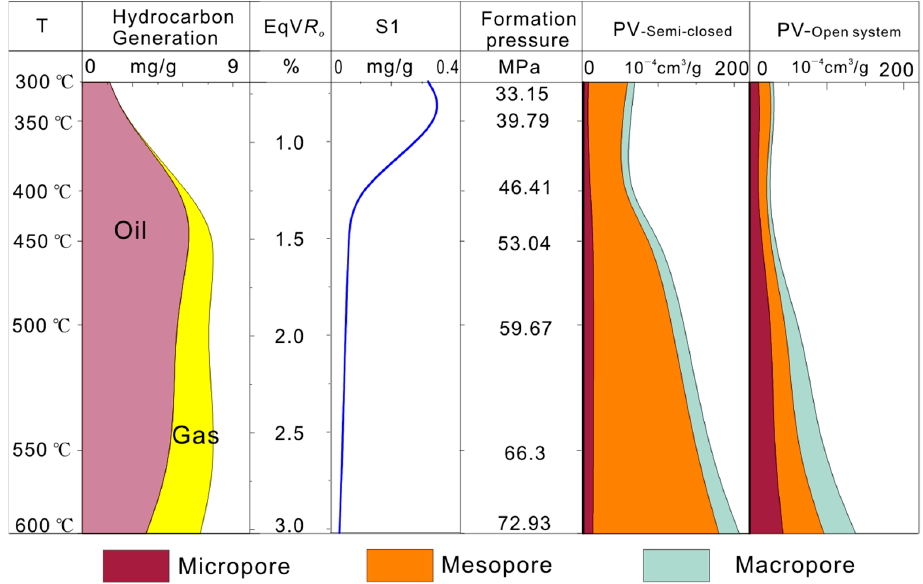
Figure 14. Pore evolution model of organic-rich marine shale based on formation pressure.